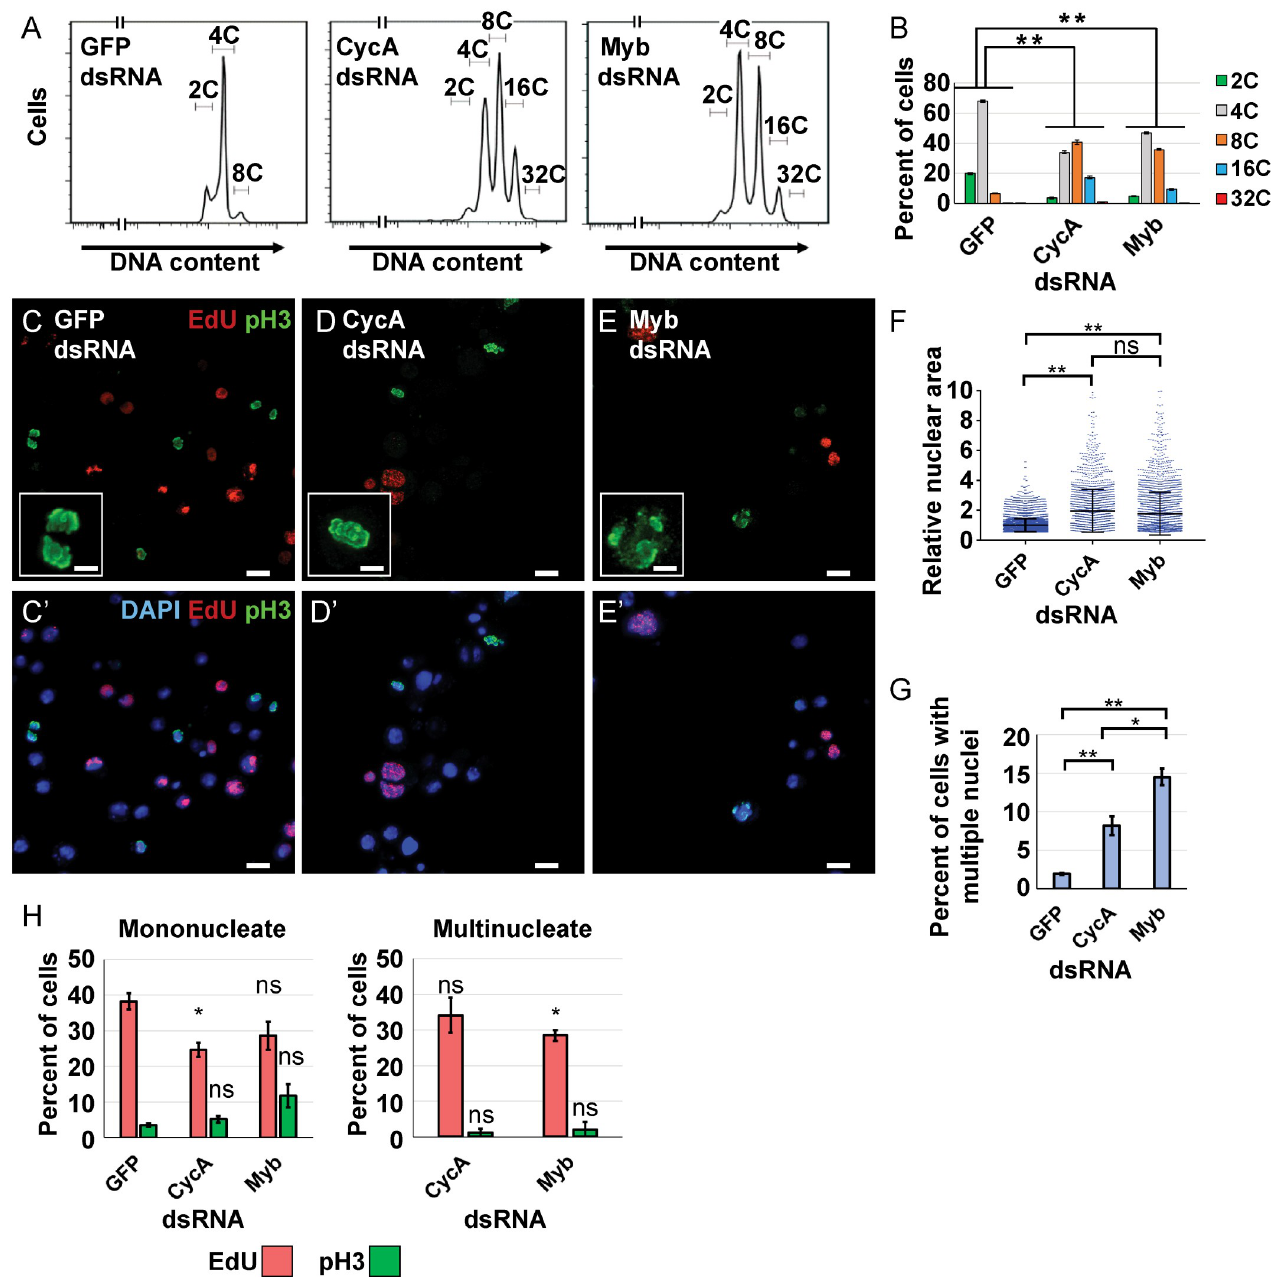
Fig 2. Myb or CycA knockdown induce similar endoreplication cycles. (A) Flow cytometry of DNA content in S2 cells treated with the indicated dsRNAs for 96 hours. (B) Quantification of the induced polyploidy after Myb dsRNA or CycA dsRNA treatment. Mean and S.E.M., N = 3, �� —p < 0.01 for each ploidy class compared to GFP dsRNA. (C-E’) Micrographs of cells labeled with EdU (red), pH3 (green) and DAPI (blue in C’-E’ ) after four days of treatment with dsRNA for GFP (control) (C,C’) , CycA (D,D’) , or Myb (E,E’) . Scale bars are 10 μ m. Insets are higher magnification of pH3 labelling. Scale bars are 3.3 μ m (F) Knockdown of CycA or Myb increases nuclear size. Quantification of nuclear area of S2 cells after knockdown of GFP, CycA or Myb. Each dot represents the nuclear area of a single cell divided by the mean area of GFP controls (machine units) (Mean and S.D. N = 3, � —p < 0.05, �� —p < 0.01, ns—not significant). (G) Quantification of the fraction of total S2 cells with multiple nuclei after the indicated treatment (mean and S.E.M. for N = 3, � —p < 0.05, �� —p < 0.01 relative to GFP dsRNA). (H) Quantification of EdU and pH3 labeling in mononucleate and multinucleate cells after treatment with the indicated dsRNAs (mean and S. E.M. for N = 3, � —p < 0.05, ns—not